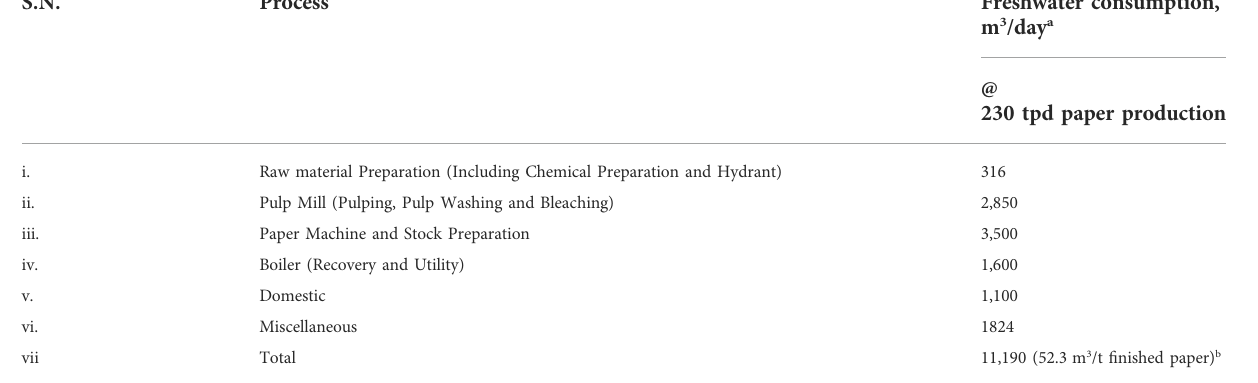
TABLE 4 Fresh water consumption in star paper mills Ltd, saharanpur, UP. S.N.